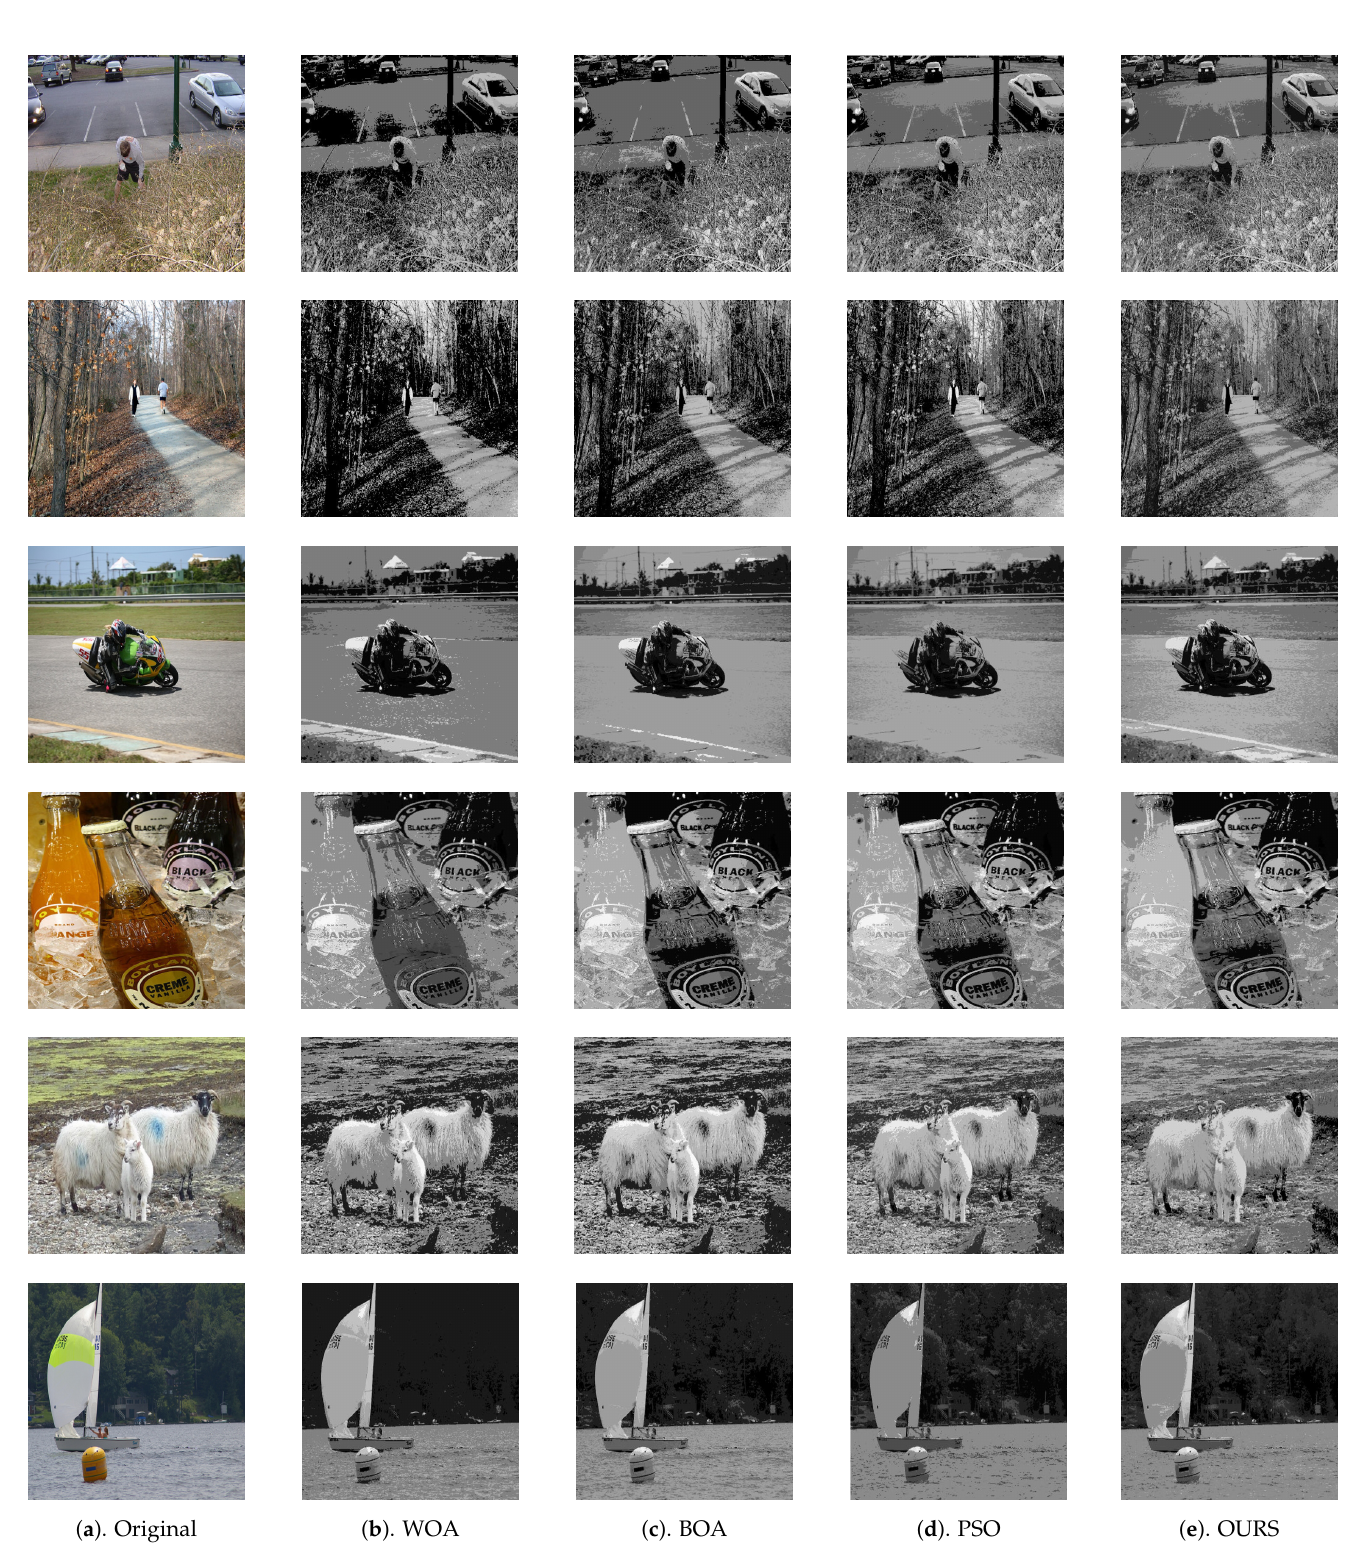
Figure 6. When threshold k = 8, the original image and the segmented image of different algorithms are shown (images a–f in Figure